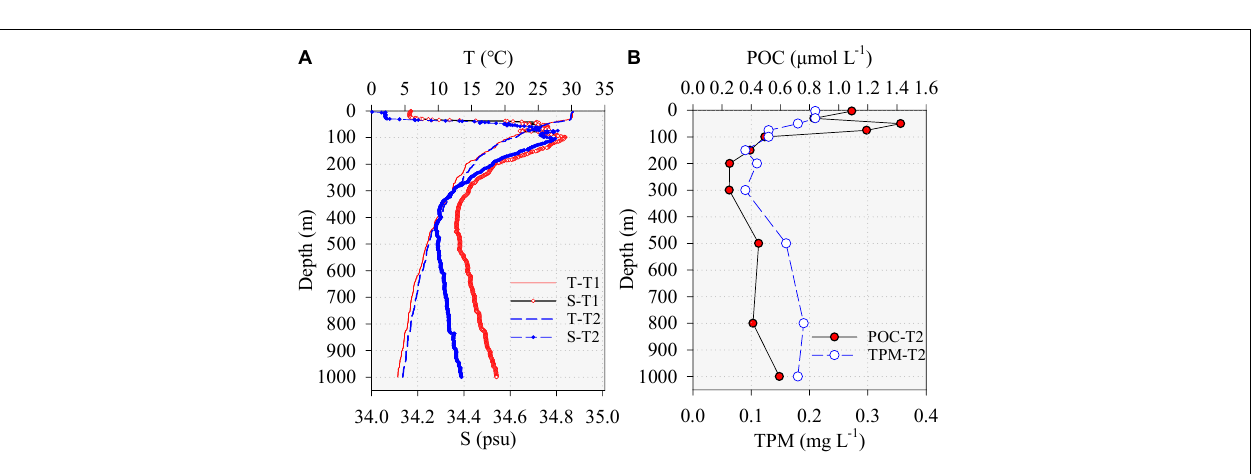
FIGURE 2 | Profiles of temperature, salinity at stations T1 and T2 (A) , and particulate organic carbon (POC) and total particulate matter (TPM) at T2 (B)